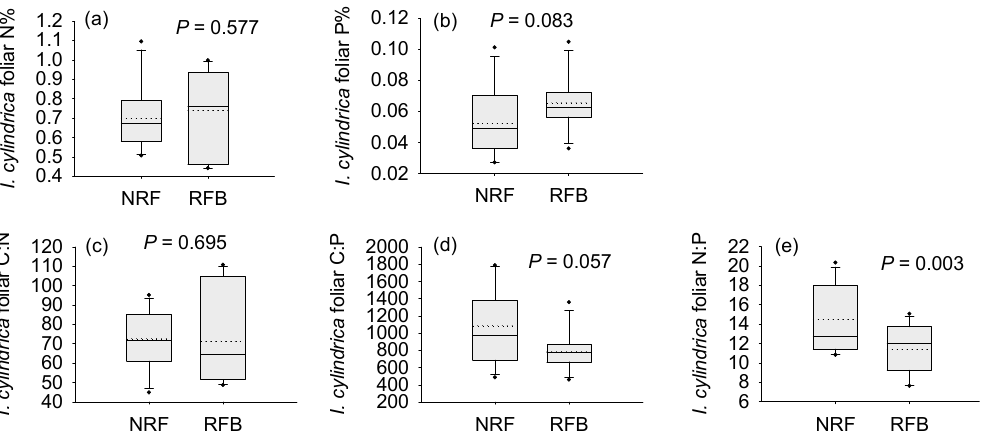
Figure 1. Box-and-whisker plots showing ( a ) nitrogen (N) content, ( b ) phosphorus (P) content, ( c ) carbon (N):N ratios, ( d ) C:P ratios, and ( e ) N:P ratios of leaves of mature Imperata cylindrica growing in areas of eucalypt forests that have either had no recent fires (NRF) or that have been exposed to recent and/or frequent burning (RFB). The NRF and RFB areas were compared using Student’s paired t -tests ( n = 11 for all variables; p -values are shown in each panel). In each box, the median is shown by the solid line and the mean is shown by the dotted line.